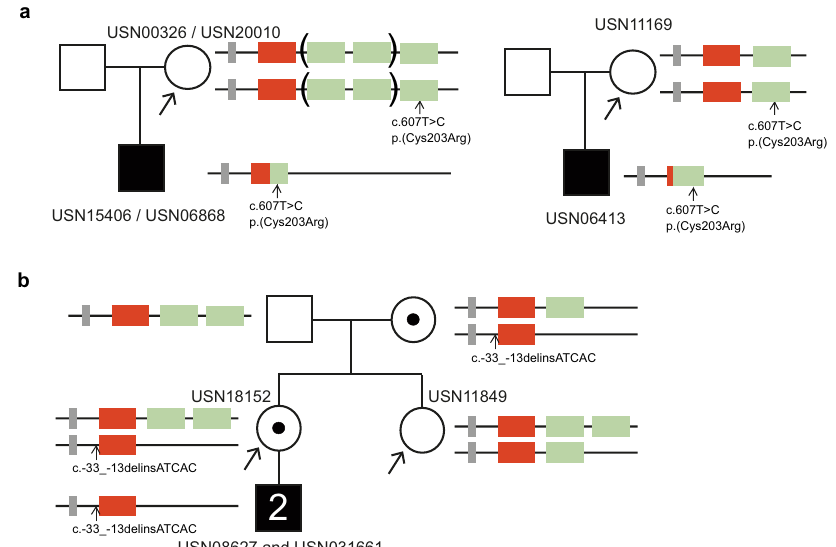
Fig. 5 Schematic overview of the pedigree and detected alleles in four clinical samples and relatives in whom carrier status analysis of the OPN1LW / OPN1MW gene cluster was performed. The individuals in whom carrier status analyses was requested are depicted with the arrow. a In three independent cases, USN00326, USN11169, and USN20010, each with a son with BCM while there was no family history of BCM, the hybrid allele with the pathogenic c.607T > C variant detected in their sons arose due to a gene recombination event in the germline or early embryonic development. b Carrier status analysis in two siblings USN18152 and USN11849. USN18152 is the mother of two affected children and carried a VUS also detected in her sons, while her sister USN11849 did not have the VUS, indicating that USN18152 was a carrier and USN11849 not. As with the current method, we can not determine the amount of opsin gene copies on each of the alleles in females, analysis of their parents (grandparents of the affected boys) was needed, to de fi nitely determine carrier status. When the parental samples were tested it was determined that USN18152 was a carrier and USN11849